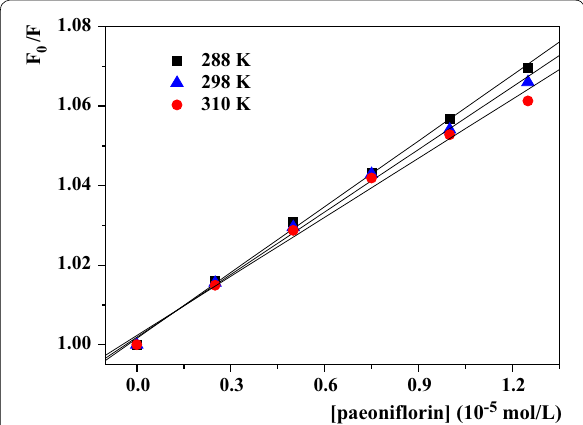
paeoniflorin solutions with + 10 − 5 to 1.25 ×